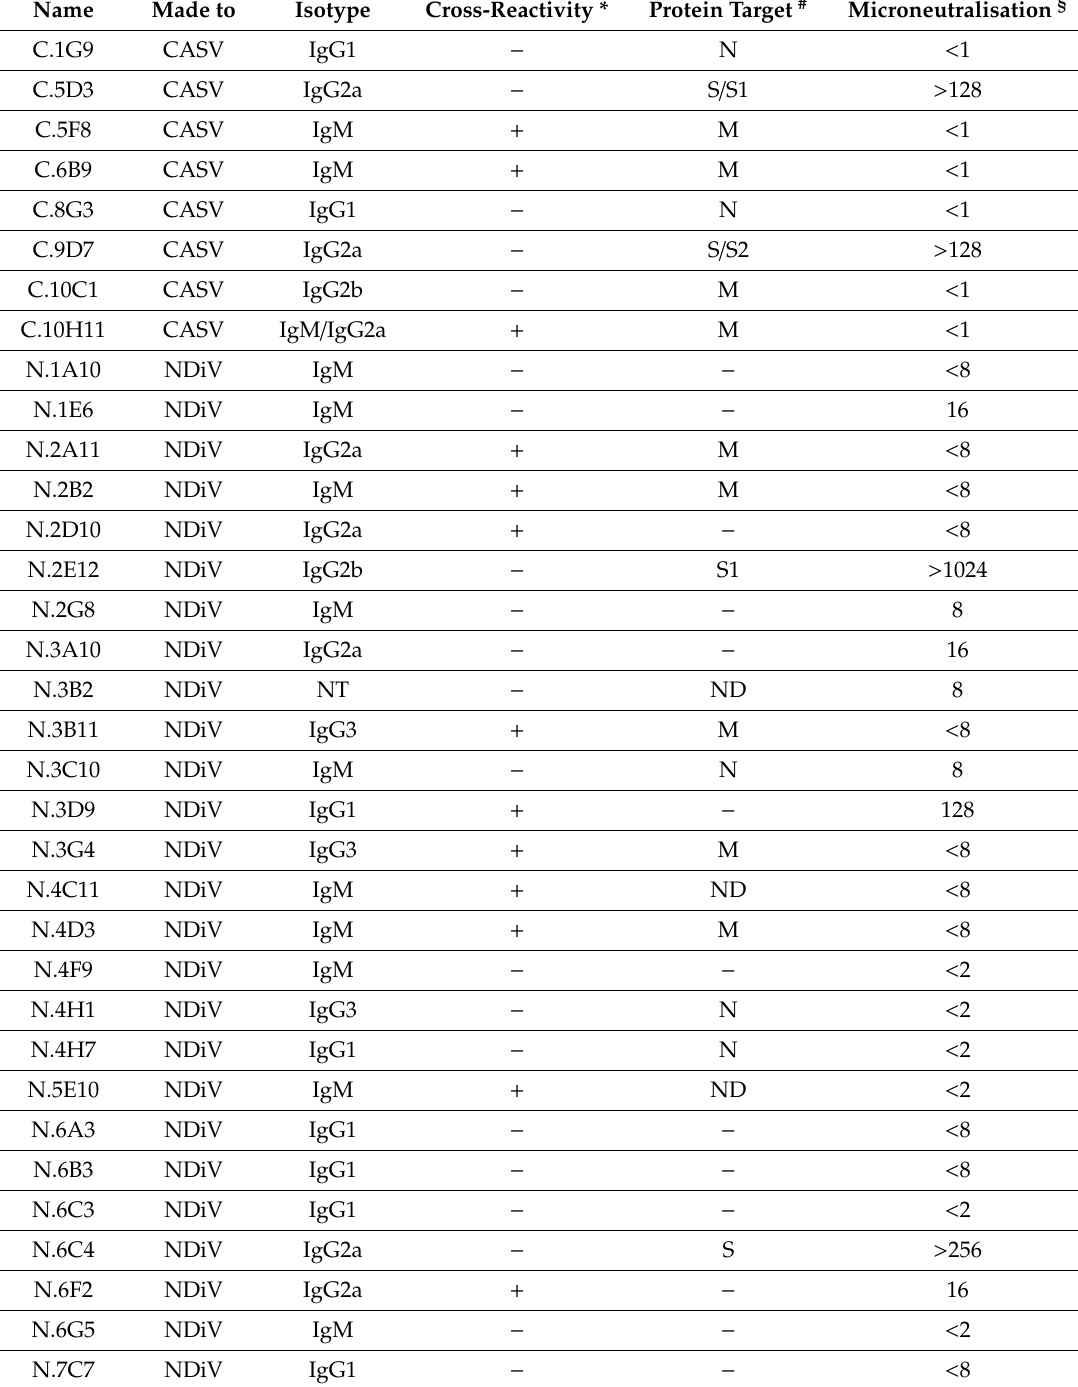
Table 3. Reactivity of mAbs towards CASV and NDiV in